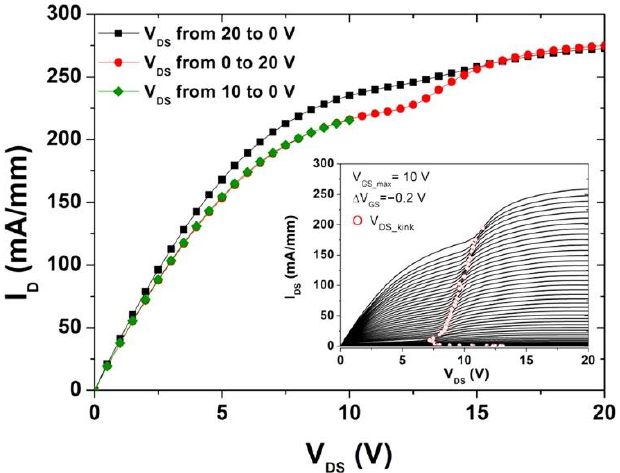
Figure 37. The kink effect in the I D is clearly observed with a strong dependence on the V DS sweep direction. Reproduced with permission [165]. Copyright 2016, the author(s), published by the American Vacuum Society.